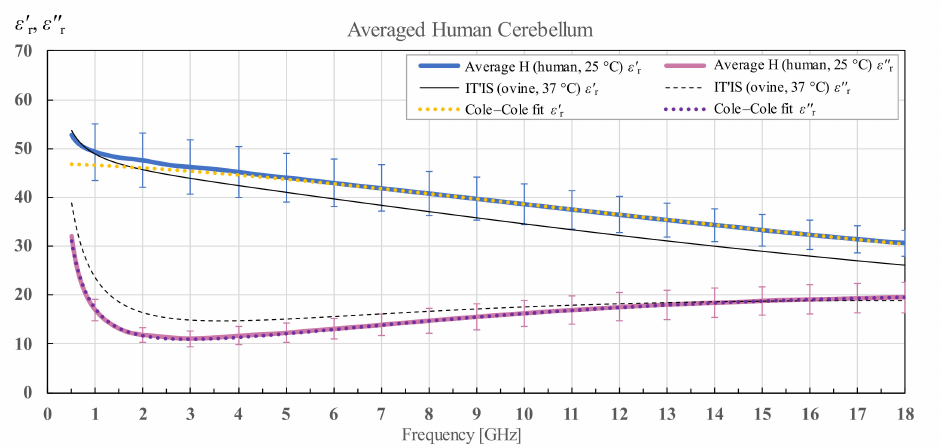
Figure 7. Permittivity of human cerebellum for brains H1 and H2 with corresponding standard deviations.